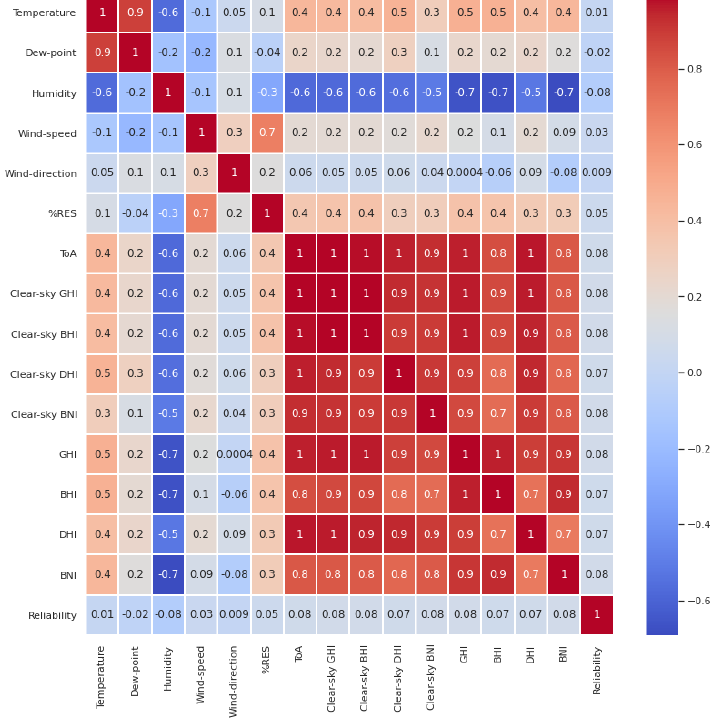
Figure 3. Results of the Pearson’s correlation analysis regarding the exogenous variables of irradiation and meteorology on the percentage of renewable energy